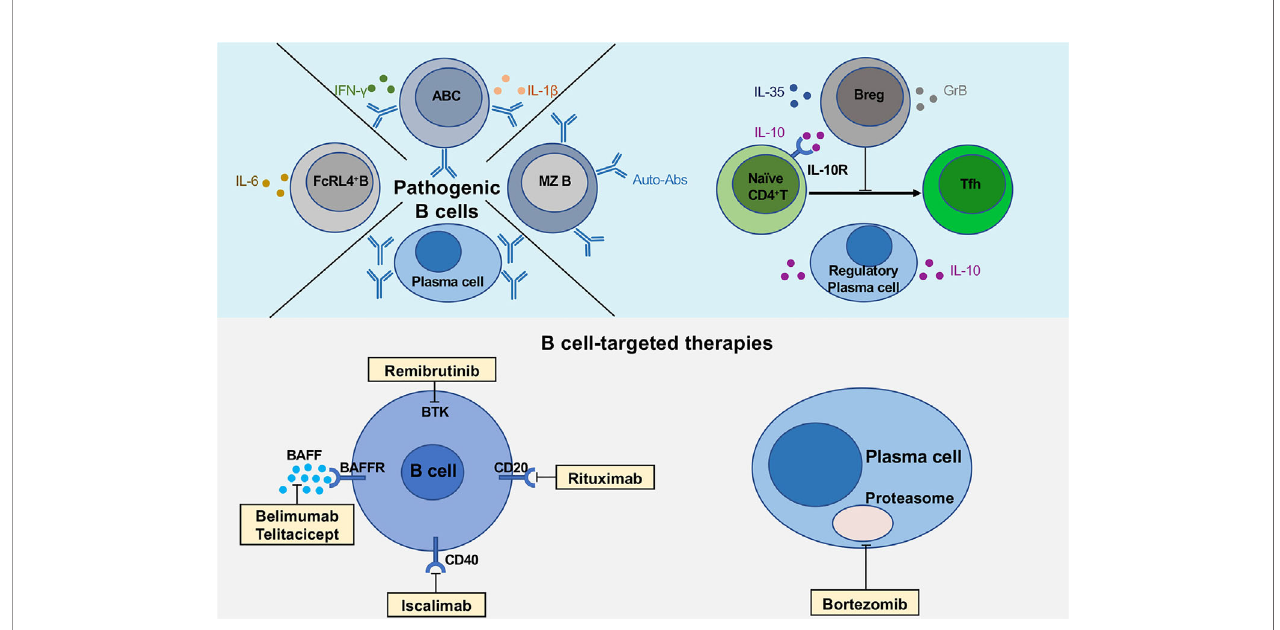
FIGURE 1 | Multiple functions of B cells and novel B cell-targeted therapies in pSS. The upper part of the fi gure shows the pathogenic B cell subsets (FcRL4 + B cells, age-associated B cells and plasma cells), regulatory B cells and plasma cells secreting various cytokines, IL-10, IL-35 and GrB. The lower part describes the multiple B cell-targeted therapies, consisting of direct and indirect B cell depletion, plasma cell